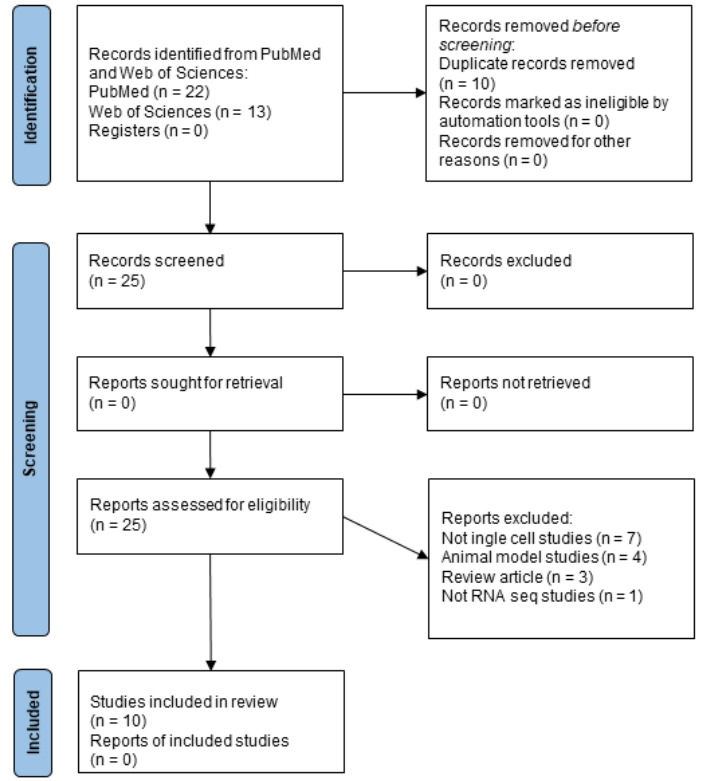
Figure 2. Prisma flow diagram of article selection for single-cell studies.